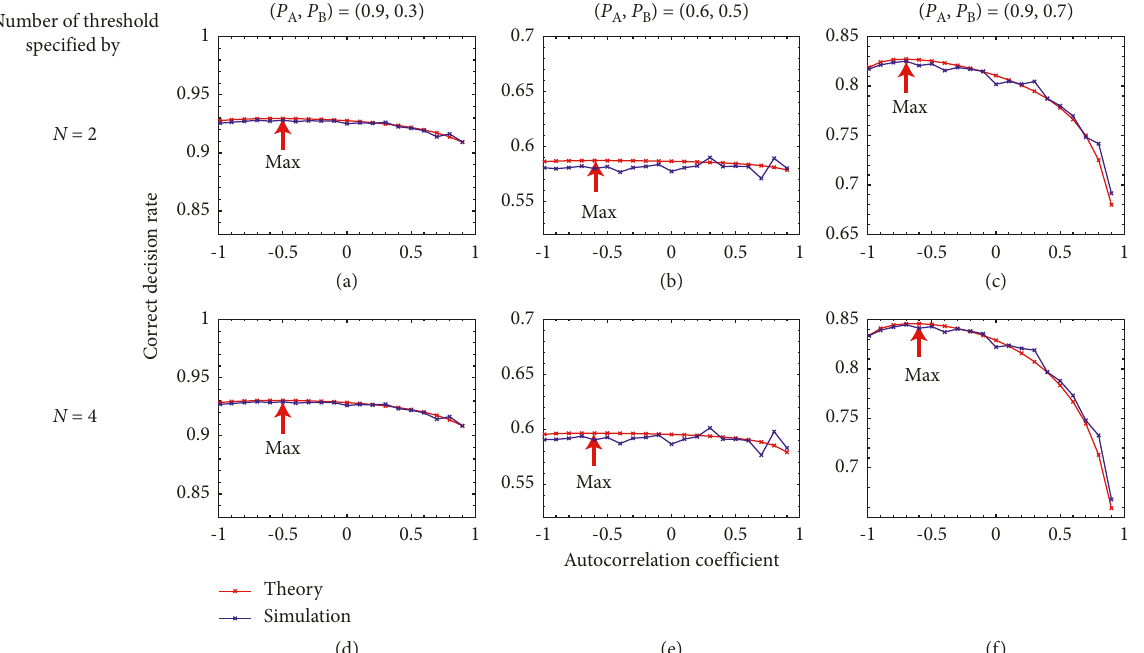
Figure 7: Correct decision rate at t � 1000 derived by the proposed theoretical model (red) and numerical simulations (blue) as a function of the autocorrelation coefficient λ . The reward probability settings and number of threshold levels are the same as in Figure 2. The threshold level is specified by N � 2 in (a)–(c), whereas N � 4 in (d)–(f). The reward probability in (a) and (d); (b) and (e); and (c) and (f) is given by ( P A , P B ) � (0.9, 0.3); ( P A , P B ) � (0.6, 0.5); and ( P A , P B ) � (0.9, 0.7), respectively.